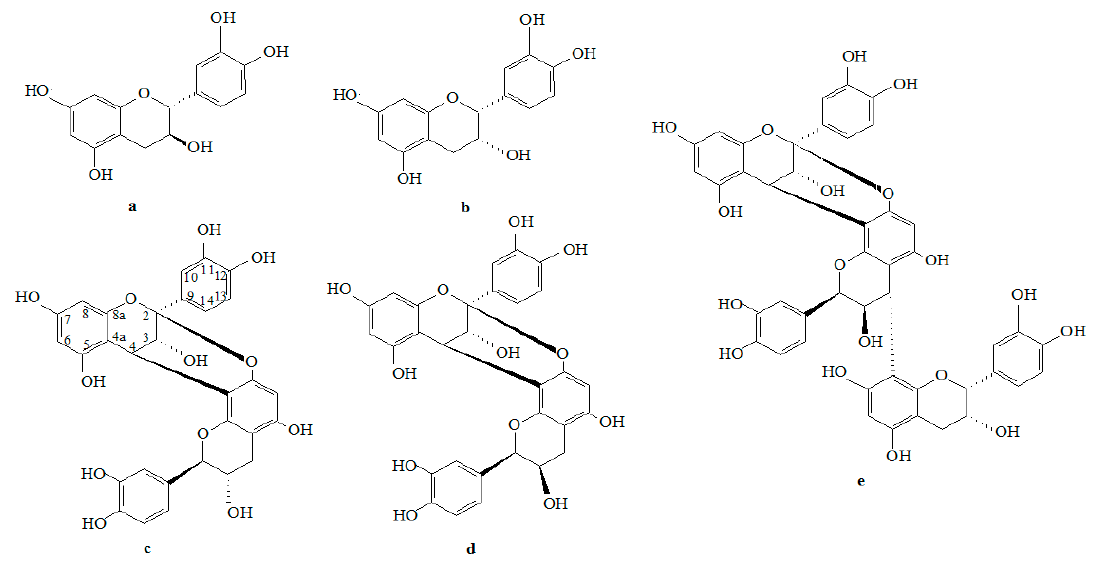
Figure 1. Structures of CC, EC, A1, A2, and A-3 in litchi pericarp ( a – e , respectively).